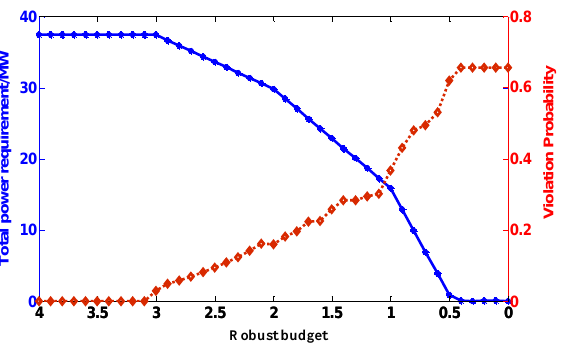
Figure 4. Power capacity of energy storage and the corresponding violation probability versus the robust